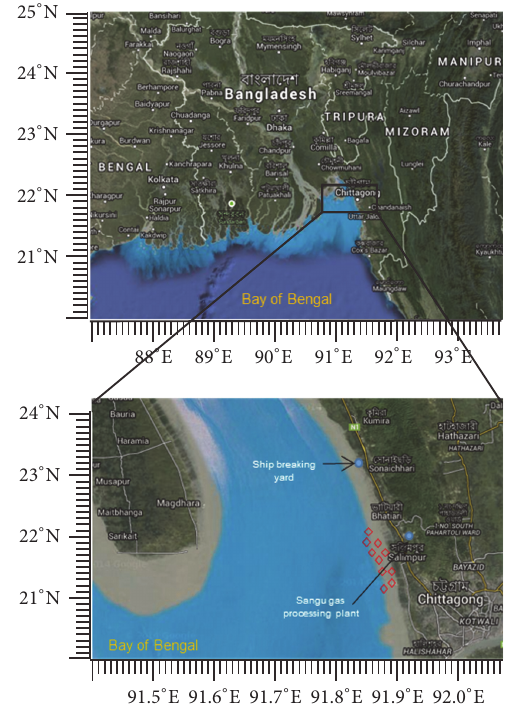
Figure 1: Map of sampling sites along the coast of Bay of Bengal. The image was taken and modified from Google Map, copyright © Google